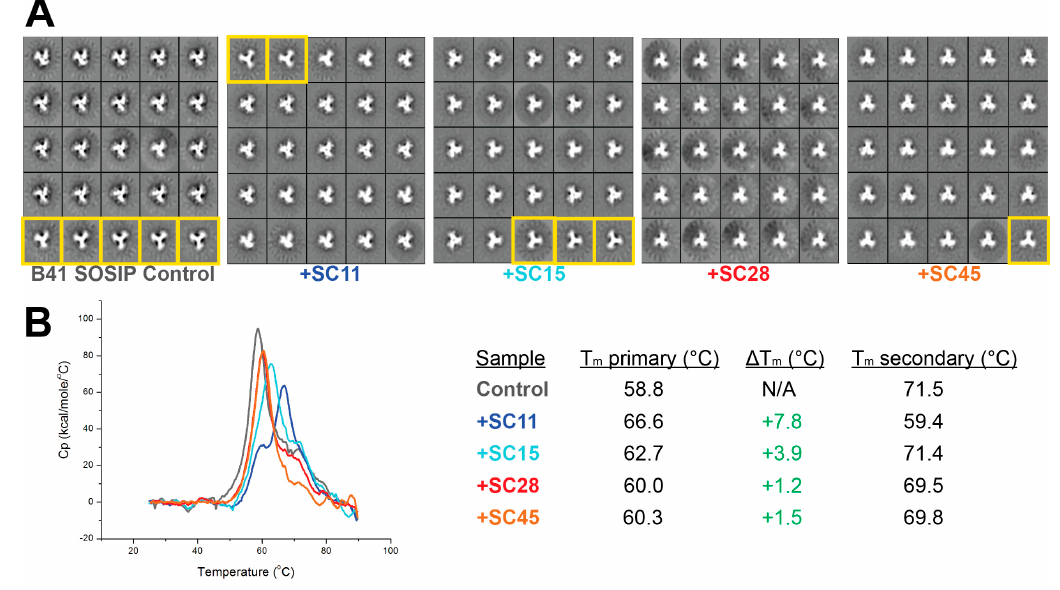
Figure 5. Biophysical characterization of B41 SOSIP.664 incubated with SC11, SC15, SC28 or SC45 . ( A ) Representative negative-stain EM 2D class averages. The control sample contained no compound. Averaged particles with phenotypes of “breathing” trimers are highlighted with yellow boxes. All samples were stained with 2% ( w/v ) uranyl formate. ( B ) Differential scanning calorimetry curves (left) and summary of melting temperatures (T m ) (right). Primary and secondary peaks are those with the highest and second highest intensity (C p , specific heat capacity), respectively. ∆ T m is the relative change from the inhibitor-free control.